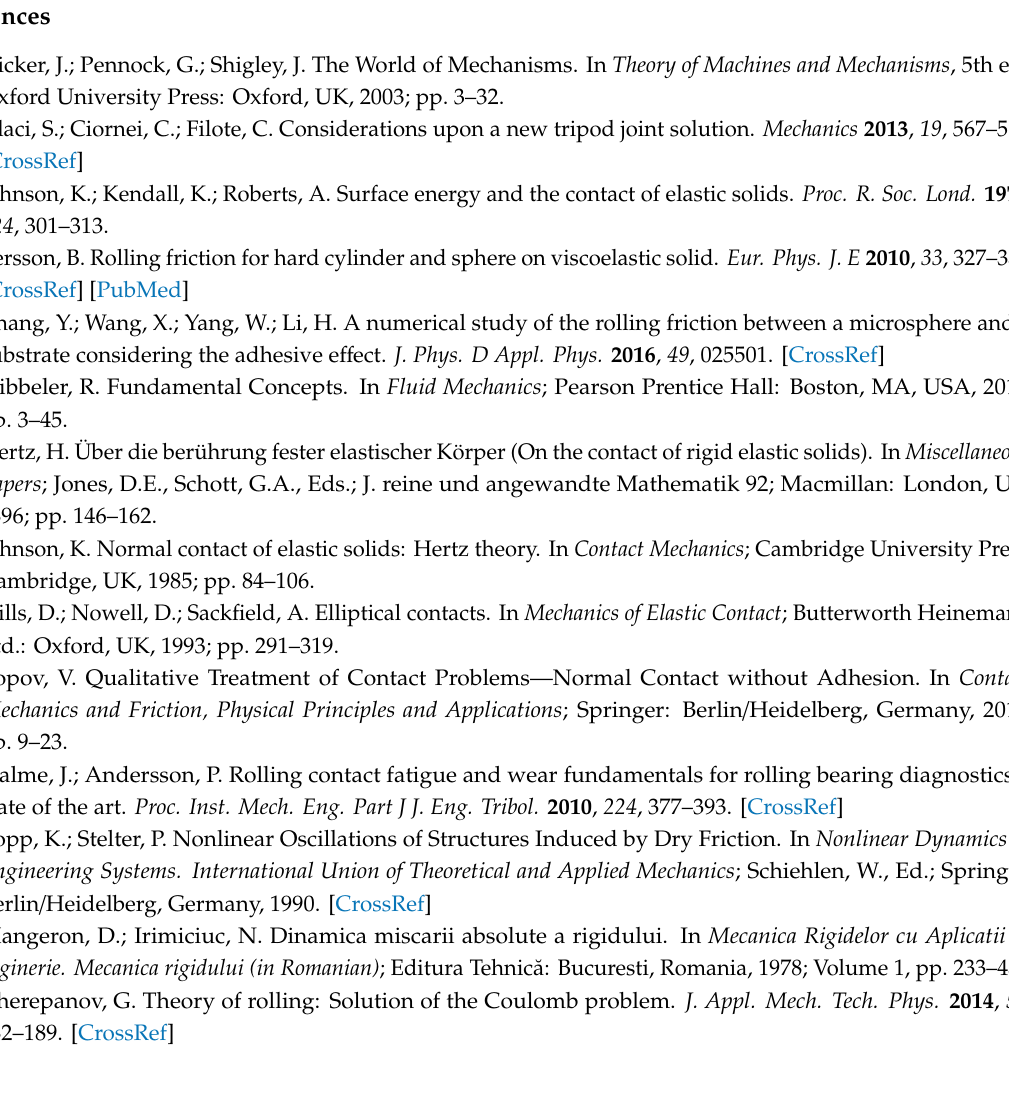
Figure A2 . Set-up for torsional oscillations. Figure A2. Set-up for torsional